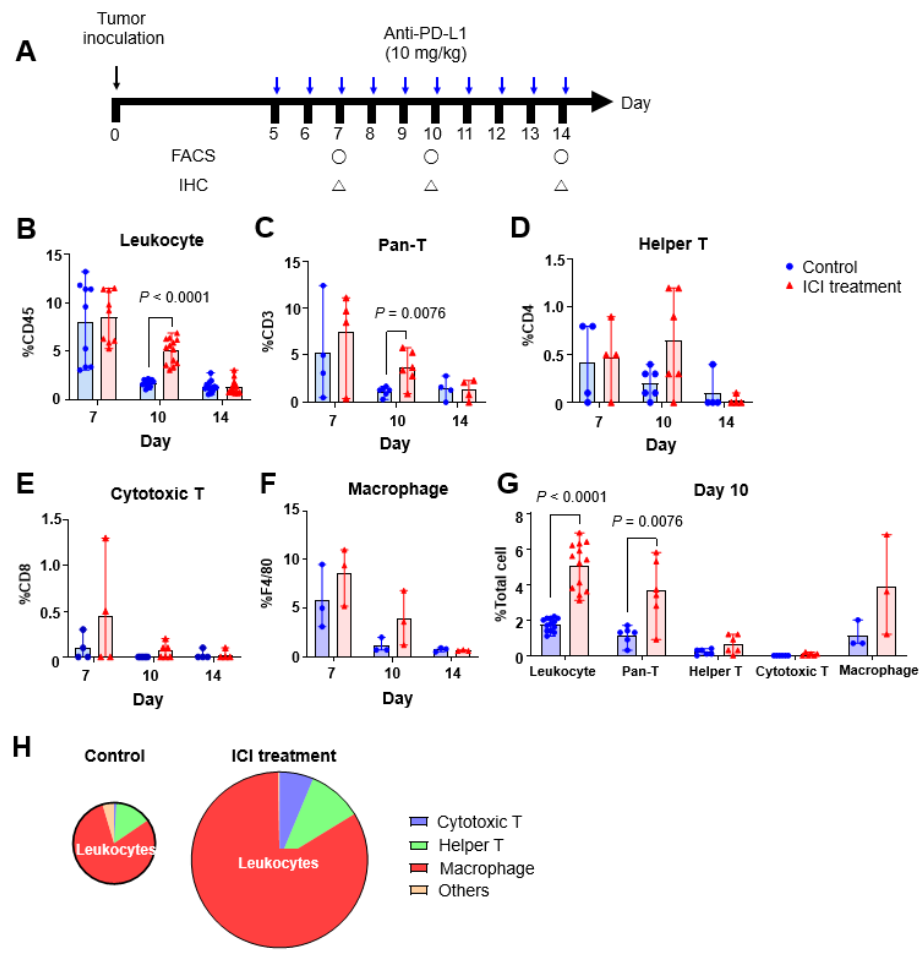
Figure 4. Cell components in tumors following ICI treatment. ( A ) Experimental scheme. After tumor inoculation, cells were isolated and analyzed at each phase of treatment. The black circle symbols mean the day on which the FACS experiment was performed, and the black triangle symbols indicate the day on which the IHC experiment was performed. ( B ) Percentage of total leukocytes (CD45+) was significantly increased in the ICI treatment group on day 10. ( C – F ) The ratios of leukocyte (CD45+) and pan-T (CD3+) cells were significantly higher in the ICI treatment group, and ( G ) Total leukocyte cell population showed higher immune cell infiltration in the ICI treatment group. Pan ‐ T cells (CD3+), helper T cells (CD4+) and macrophages (F4/80+) showed a significantly higher percentage on day 10, indicating higher immune cell infiltration in tumors treated with ICI. ( H ) Absolute number of immune cells was also higher in the ICI treatment group. The y ‐ axis of ( B – F ) means the count percentage of each cell markers in total cells population from tumor.